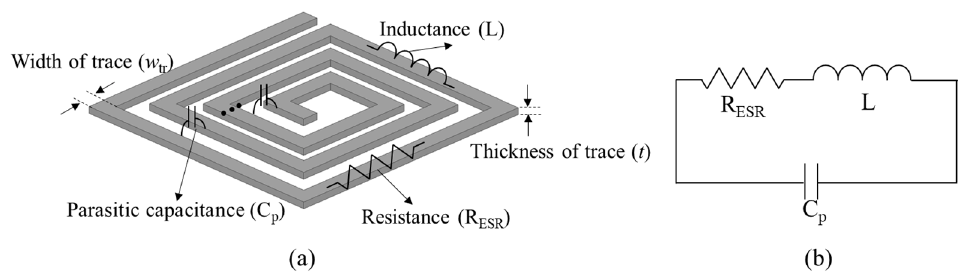
Figure 2. Simplified coil model. ( a ) The coil is composed of conductive trace which accompanies the resistance and inductance. The parasitic capacitance can be developed between the traces. ( b ) Equivalent circuit of coil.